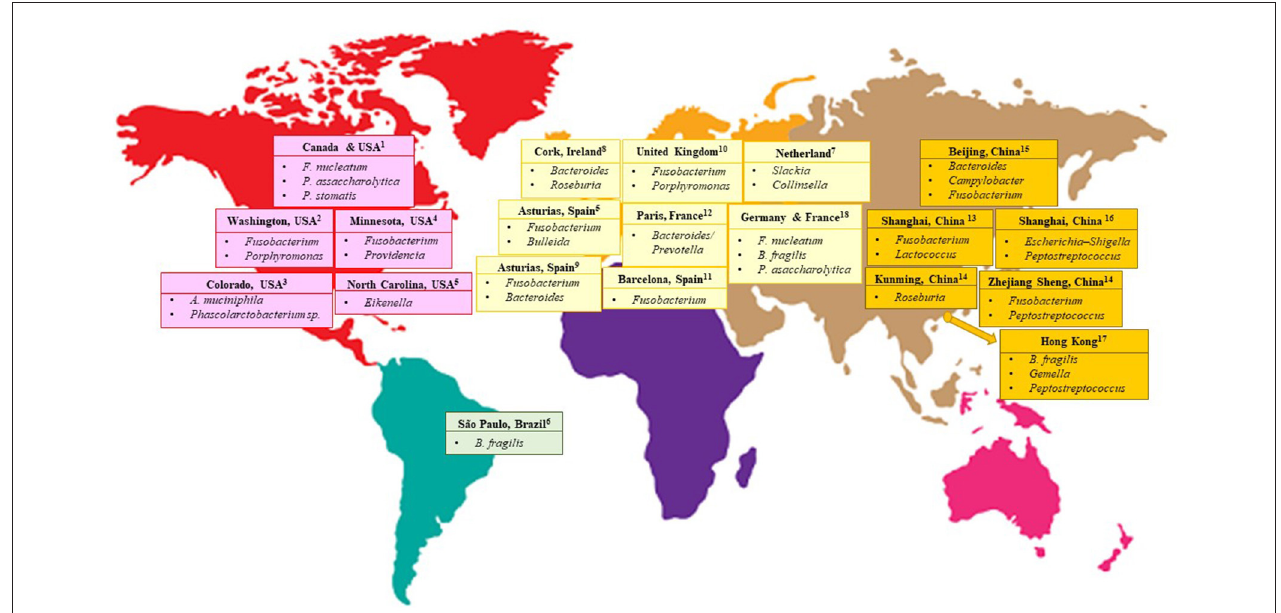
FIGURE 1 | CRC-associated bacteria from different geographical locations of the world. 1 (Baxter et al., 2016) 2 (Ahn et al., 2013; Sinha et al., 2016) 3 (Weir et al., 2013) 4 (Burns et al., 2015) 5 (Allali et al., 2015) 6 (Thomas et al., 2016) 7 (Marchesi et al., 2011) 8 (Flemer et al., 2017) 9 (Mira-Pascual et al., 2015) 10 (Zackular et al., 2014 ) 11 (Kostic et al., 2012) 12 (Sobhani et al., 2011) 13 (Gao et al., 2015) 14 (Geng et al., 2013) 15 (Wu et al., 2013) 16 (Wang et al., 2012) 17 (Nakatsu et al., 2015) 18 ( Zeller et al.,